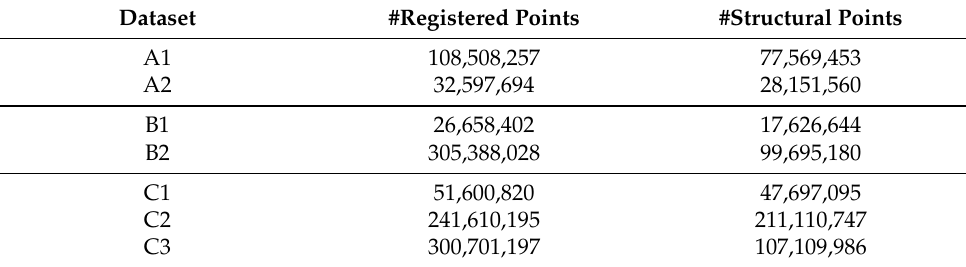
Table 3. Number of registered point cloud and structural